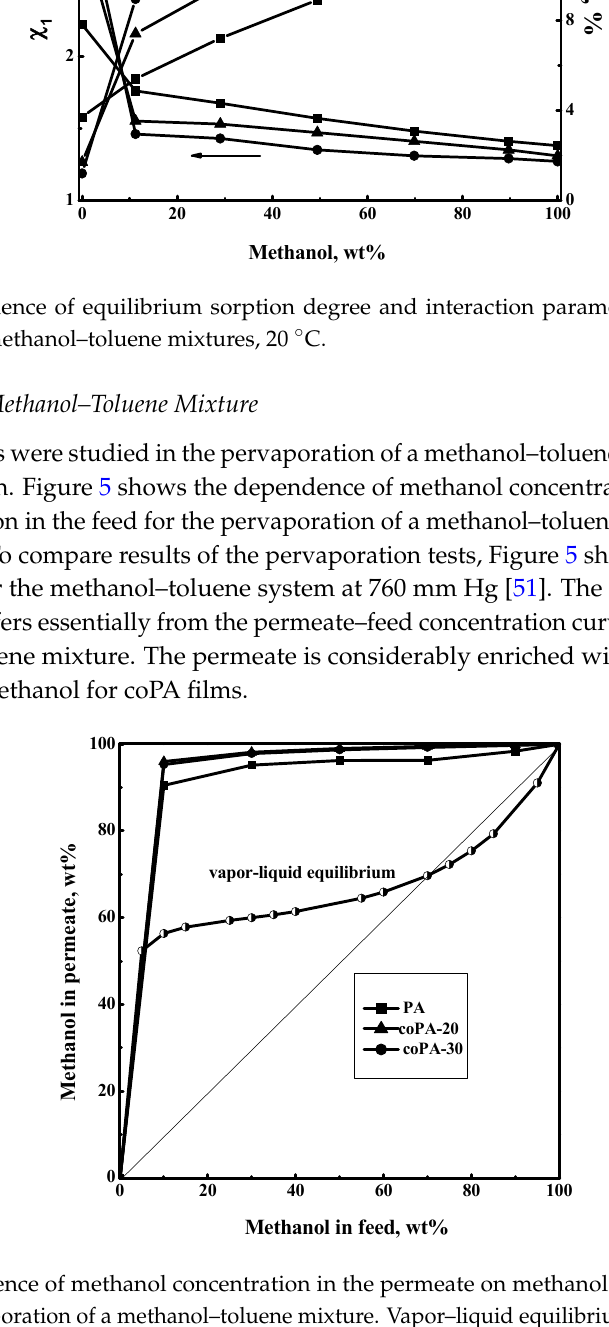
Figure 4. Dependence of equilibrium sorption degree and interaction parameter (cid:2031) (cid:2869) on methanol concentration in methanol–toluene mixtures, 20 °C.